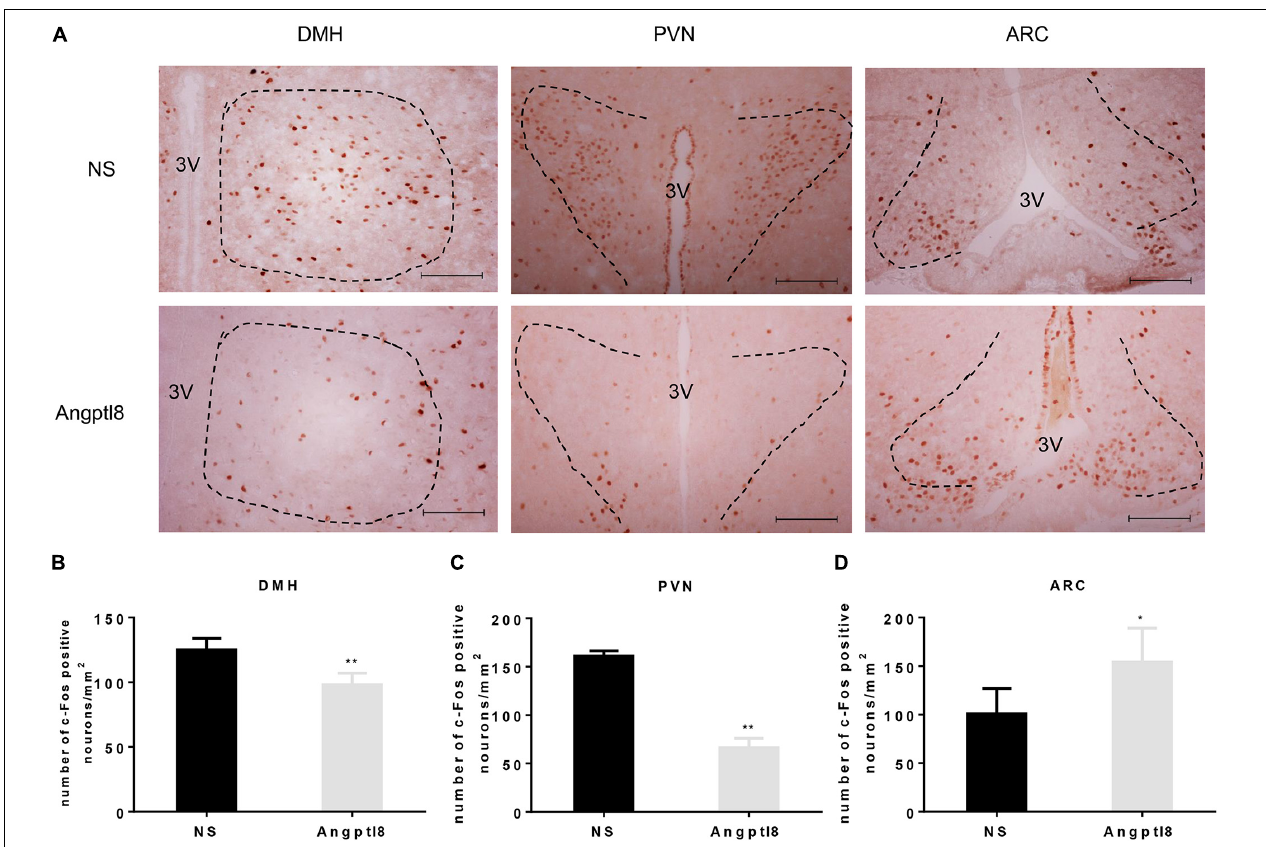
FIGURE 4 | Central Angptl8 influenced c-Fos-positive neurons expression in the PVN, DMH, and ARC. (A) Changes in c-Fos-positive neurons in the hypothalamus 2 h after I.C.V. injection with NS and Angptl8. (B–D) The numbers of c-Fos immunoreactive cells in the DMH ( n = 5), PVN ( n = 3), and ARC ( n = 6) are expressed as means ± SEM. ∗ P < 0.05, ∗∗ P < 0.001 relative to the NS control group. Scale bar in A = 100 µ